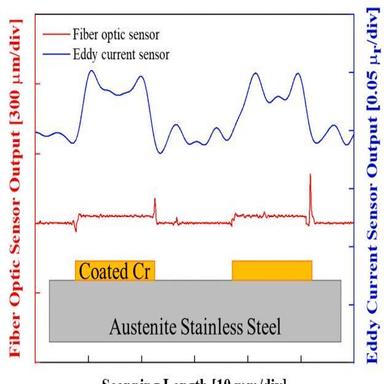
Profiles obtained by the scanning system using the fiber optic eddy